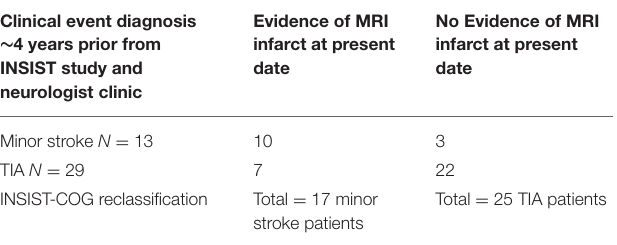
Clinical event diagnosis ∼ 4 years prior